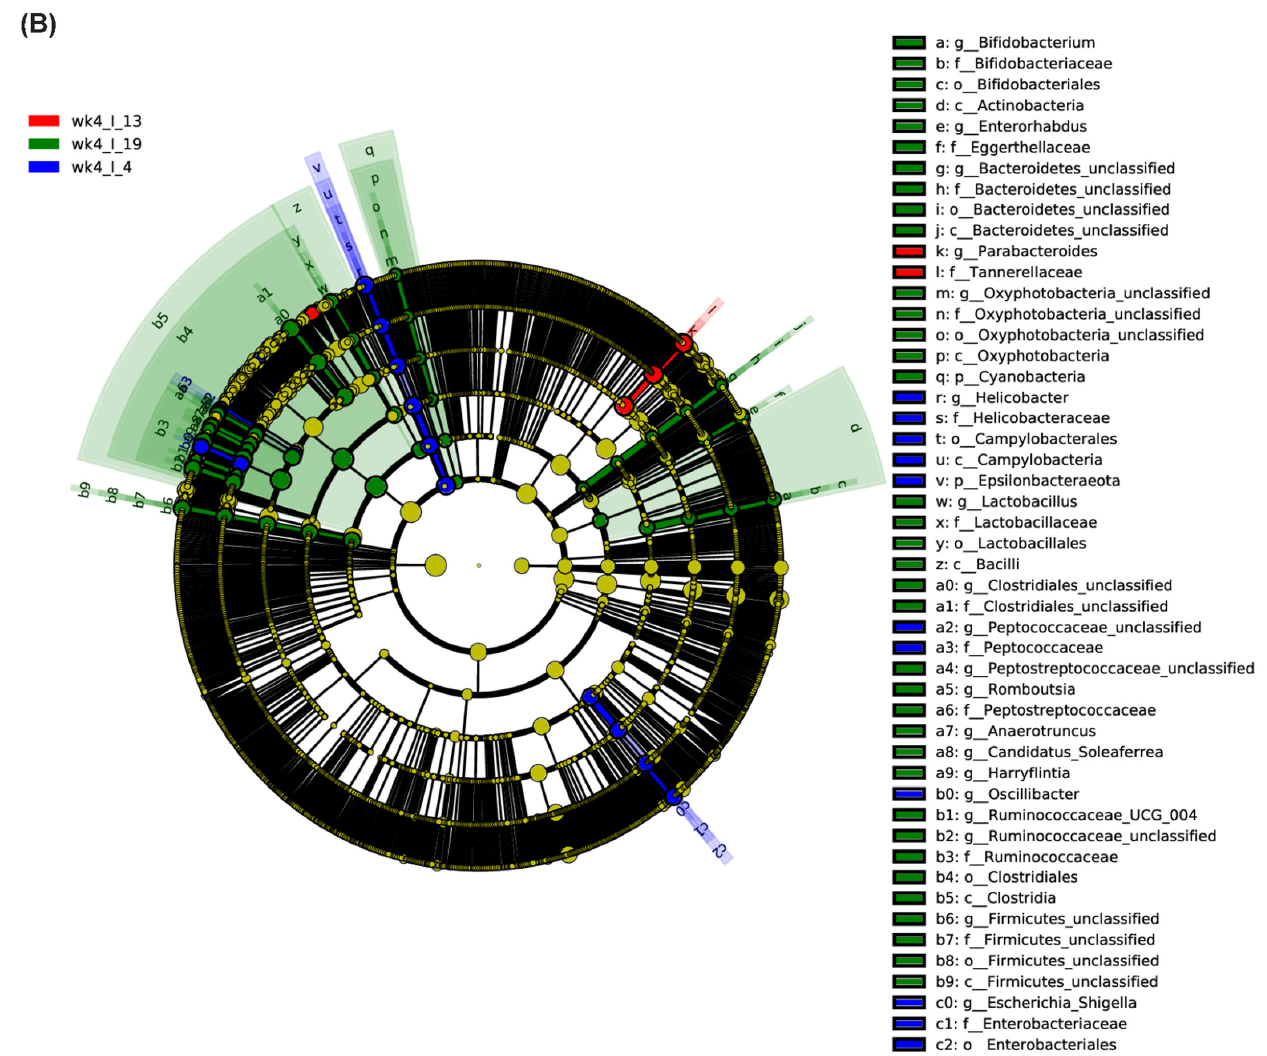
Figure 5. Linear discriminant analysis effect size (LEfSe) analysis of sugar beet genotypes at 4 weeks (wk4). Hierarchal taxonomic cladogram displaying potential biomarkers of beet curly top virus in the ( A ) control, and ( B ) BCTV-infected susceptible and resistant sugar beet genotypes. 19, susceptible genotype; 13 and 4, resistant genotypes; C = uninfected control, and I = BCTV-infected. 2.3. Predicted KEGG Pathways Were Differentially Regulated in the Resistant